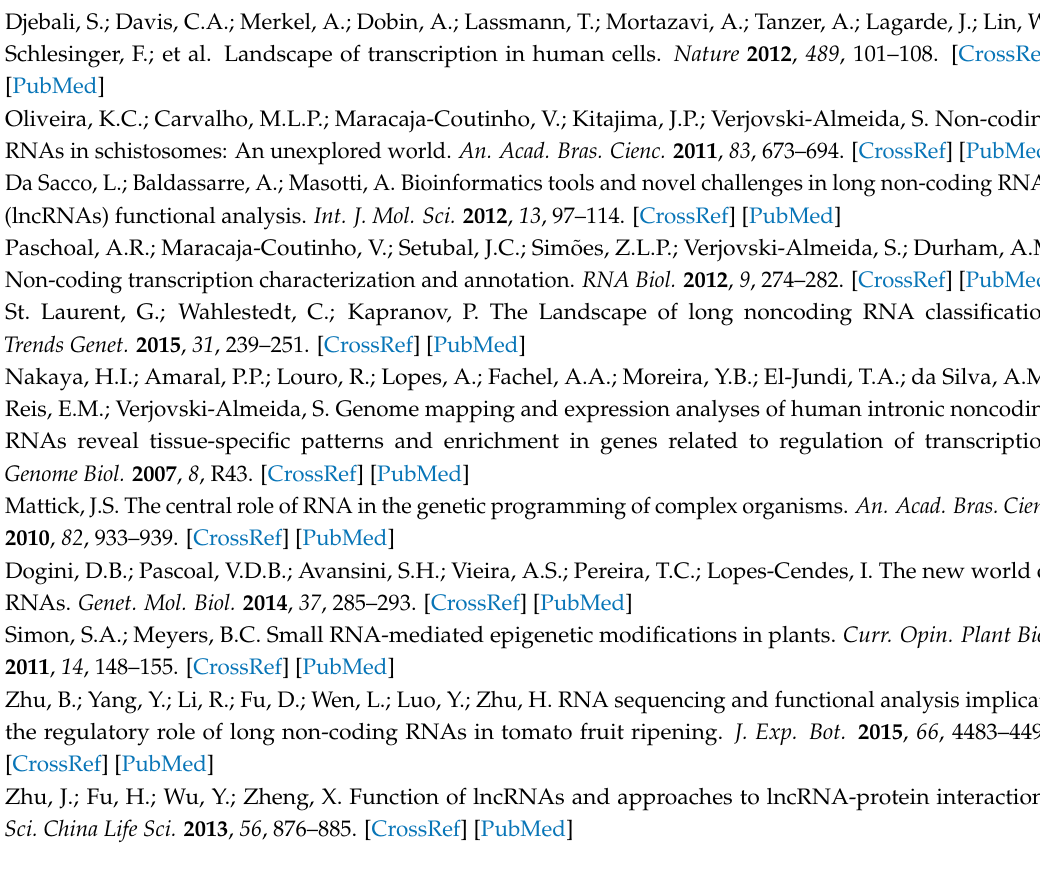
quantitative PCR validation. Table S2: Chromosomal distribution of Lluteño lncRNAs according to B73 genome sequence and protein coding genes. Table S3: Excel table of the Pearson correlations between the expression levels of Lluteño lncRNAs and the closest coding genes according to B73 genome. Table S4: Excel table of differentially expressed lncRNAs. The table contains the expression values, fold-changes for each condition and its presence in other maize genomes (B73, Palomero and MO17). Table S5: Gene Ontology enriched categories of Table S6: Gene Ontology enriched categories of lncRNA-coding gene trans -NAT pairs. P = Biological Process, C = Cellular Component, F = Molecular